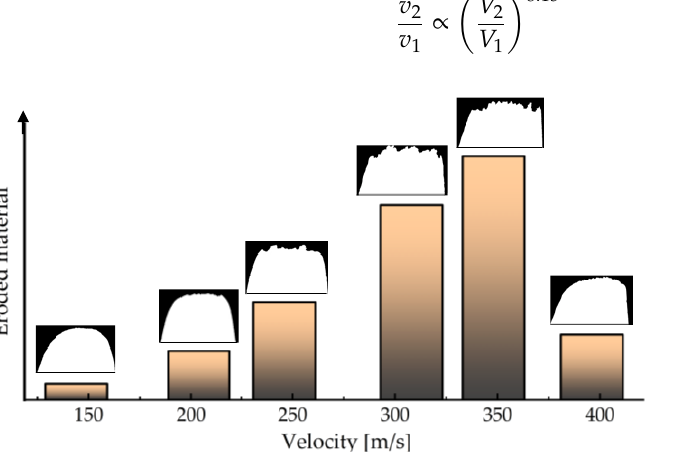
Figure 5. A comparison of the cross-section profiles of the ex-service turbofan leading edge. Repro- duced from [37].